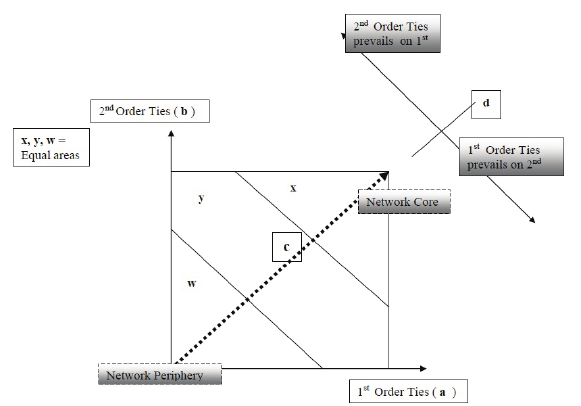
Figure 1. A grid for organizational networking analysis Bianchi and Tampieri